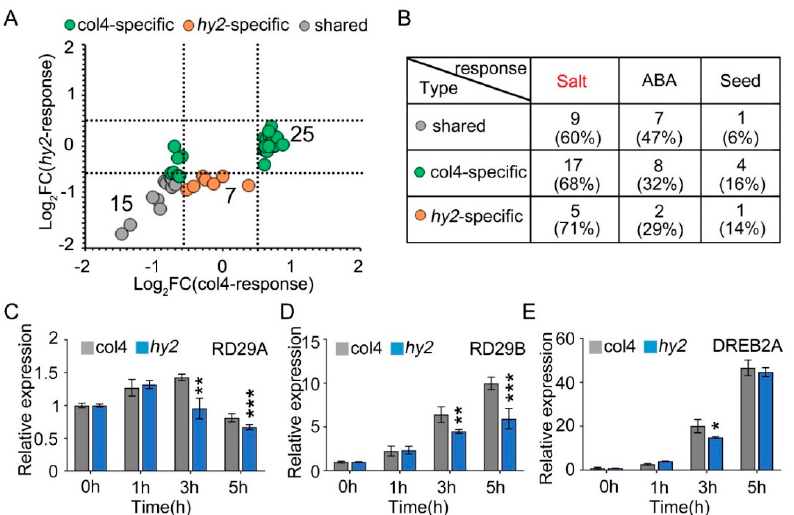
Figure 7. The expression of stress-responsive genes. ( A ) Protein expression pattern of col4 and hy2 shared proteins involved in salt, ABA, and seed-related pathway. Color denotes proteins regulated similarly by col4 and hy2 (grey), or specifically by col4 (green) or hy2 (orange). ( B ) The number and proportion of col4 and hy2 shared proteins involved in salt, ABA, and seed-related pathway. ( C – E ) The expression of RD29A , RD29B , and DREB2A in col4 and hy2 mutant seedlings treated with exogenous NaCl. The 5-day-old col4 and hy2 mutant seedlings were transferred to 1/2 MS solution with or without 200 mM NaCl for 0 - 5 h, and then the seedlings were harvested for QPCR. Data are shown as mean ± SD ( n = 3). Asterisks showed in ( B – D ) indicate statistically significant differences compared with relevant col4 plants: * p < 0.05, ** p < 0.01, *** p < 0.001.